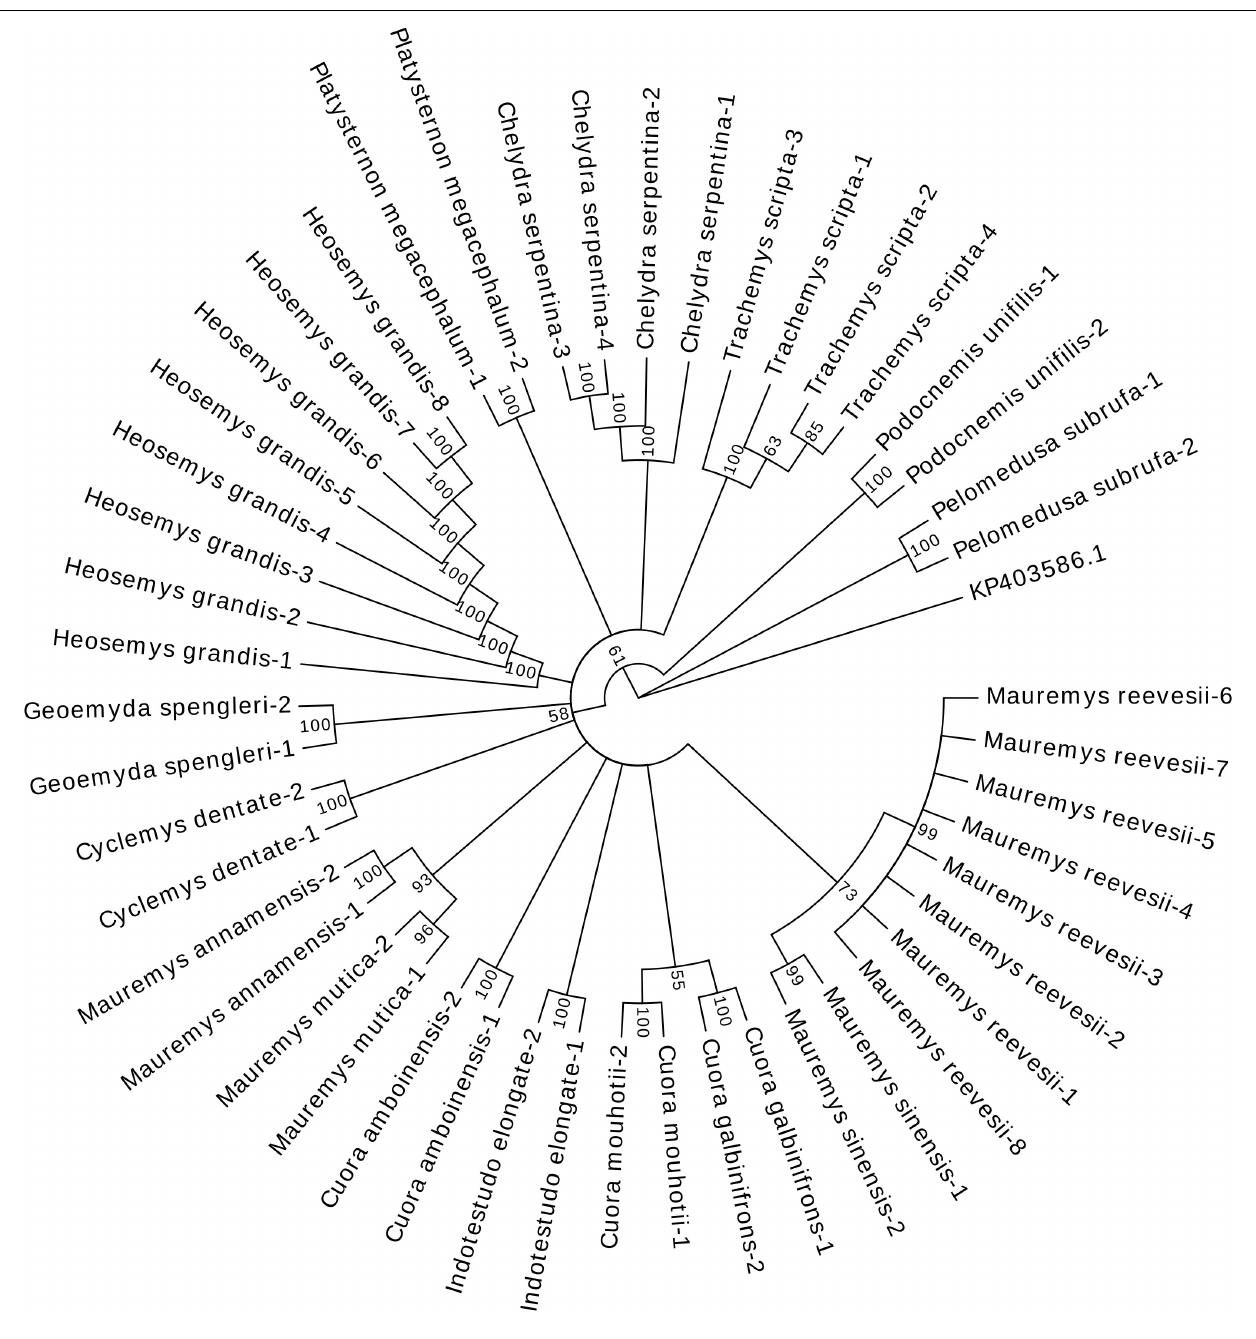
FIGURE 4 | Results of the neighbor-joining tree based on HG sequences of the 48 turtle samples. The value represented the percentage of these branches in the bootstrap test, indicating whether the data adequately support their associated partitions. The closer to 100, the higher the